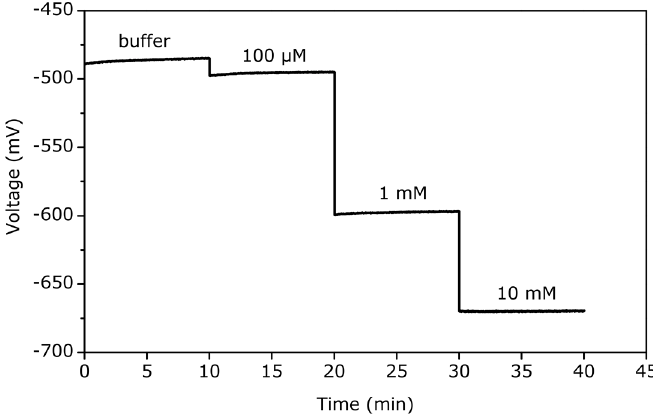
Figure 3. ConCap response of the TMV-based field-effect biosensor recorded in solutions with different penicillin